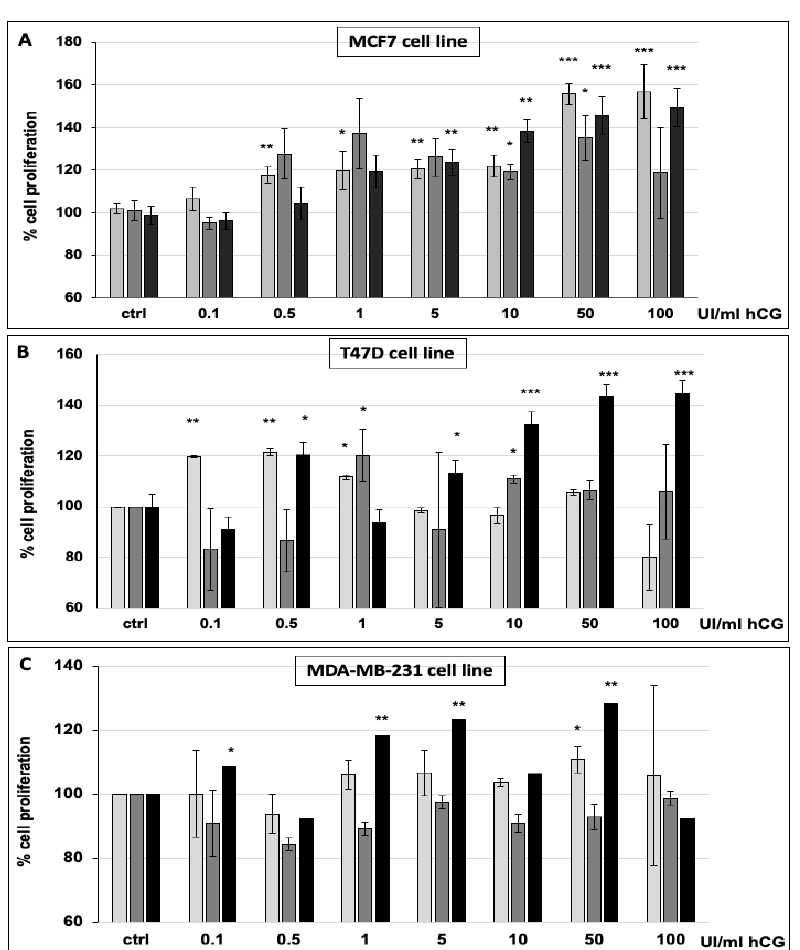
Figure 2. Cell proliferation of MCF7 ( A ), T47D ( B ), and MDA-MB-231 ( C ) cultured in FBS-deprived medium and treated with 0.1, 0.5, 1, 5, 10, 50, or 100 UI/mL human chorionic gonadotropin (hCG) for 24, 48, or 72 h. Histogram legend: 24 h treatment (light gray); 48 h treatment (dark gray); 72 h treatment (black). Values are the means ( ± SD) of three independent biological replicates. Statistical legend: p < 0.5 (*), p < 0.01 (**), p < 0.001 (***) for treated cells relative to untreated cells